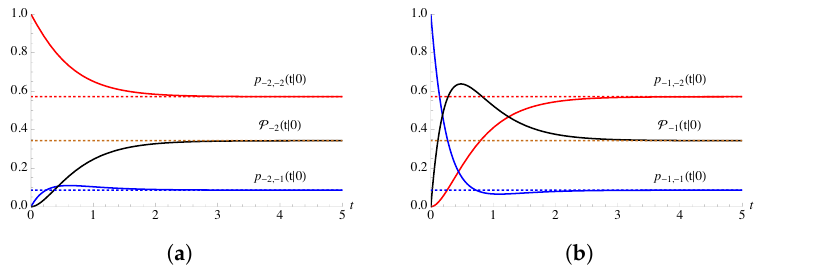
Figure 2. The probabilities p j , − 1 ( t | 0 ) , p j , − 2 ( t | 0 ) and P j ( t | 0 ) are plotted for ϕ ( t ) = 1 and for ξ = 1.0, (cid:36) = 0.6, ν = 4.0. In ( a ) j = − 2 (failure state) and in ( b ) j = − 1 (repair state).